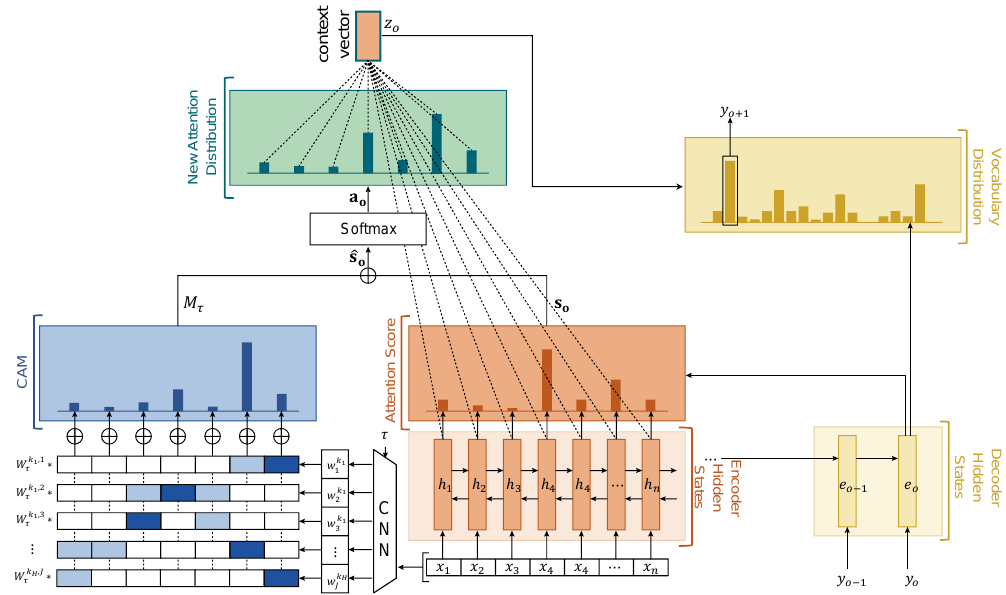
Figure 2. Overall structure of topic category-aware neural